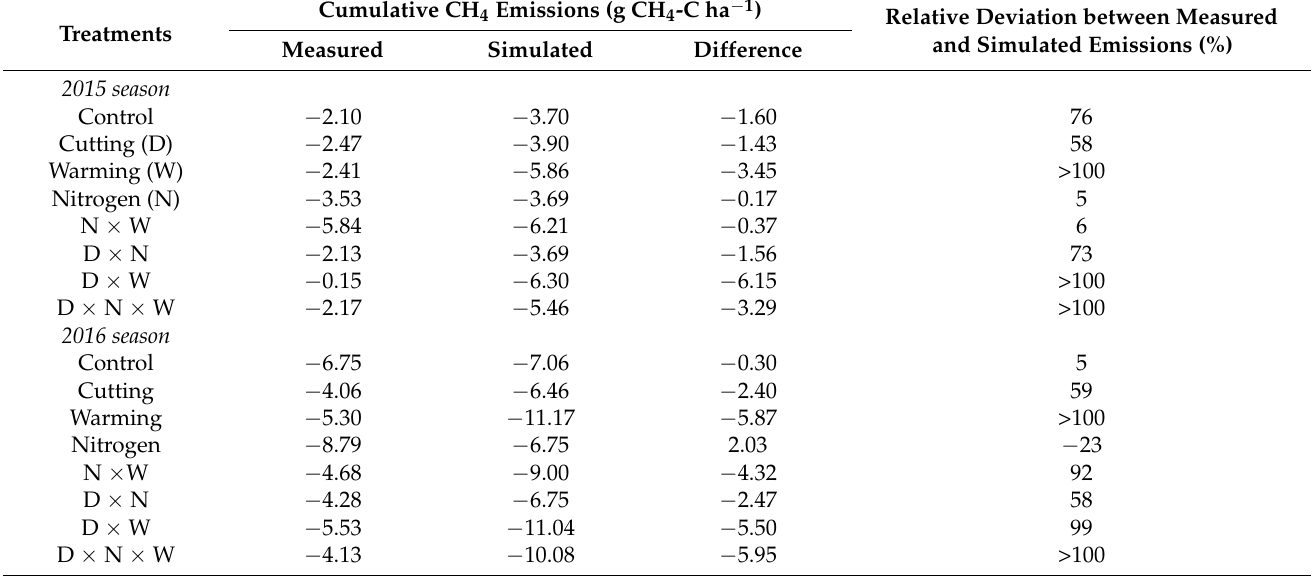
Table 4. Measured and DNDC-simulated cumulative CH 4 emissions (g CH 4 -C ha − 1 ) for the full factorial experiment over two growing